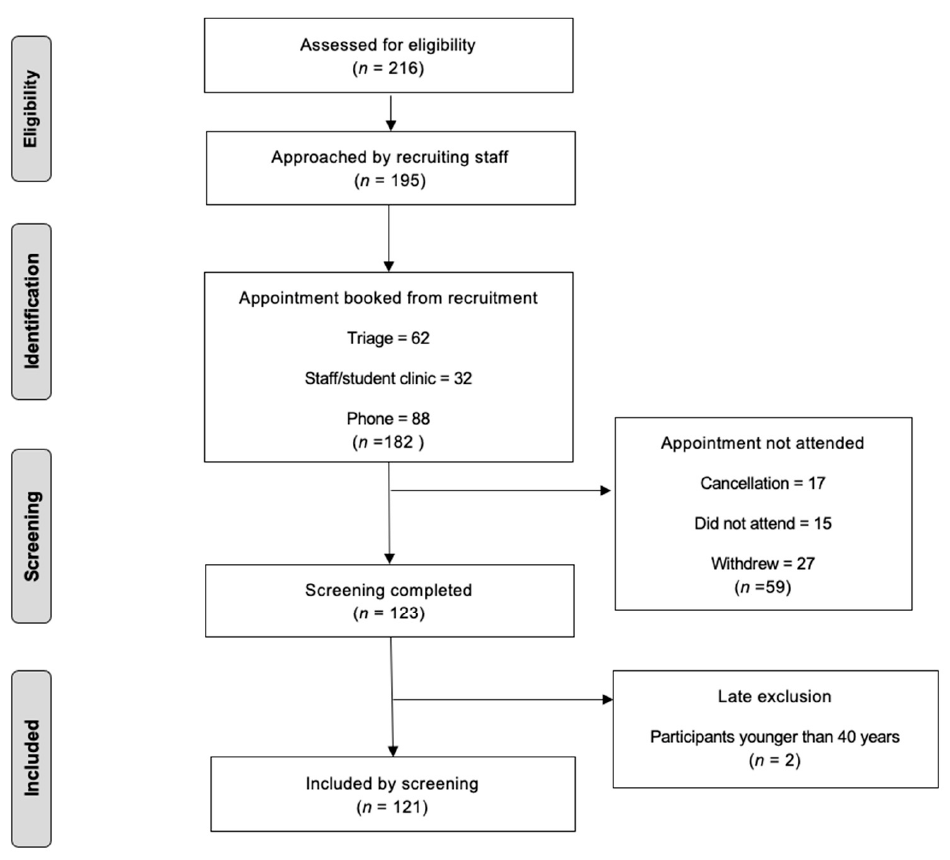
Figure 4. Consort figure displaying the total number of participants that completed a return case- finding appointment at Peninsula Dental School ( n = 123) following their recruitment at an earlier appointment at least 1 week previously ( n = 182). Table 1. Population characteristics, (mean ± SD) to 1 d.p. BMI—body mass index, BP—blood pressure, SD—standard